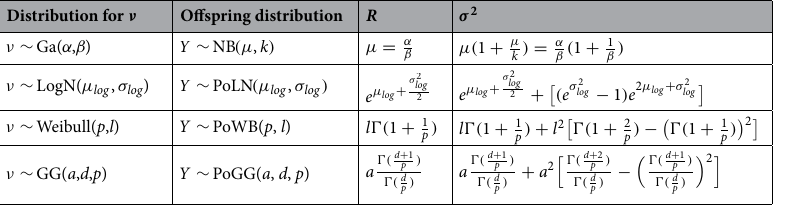
Table 3. Different mixture distributions, assuming a Poisson distribution for the effective contact